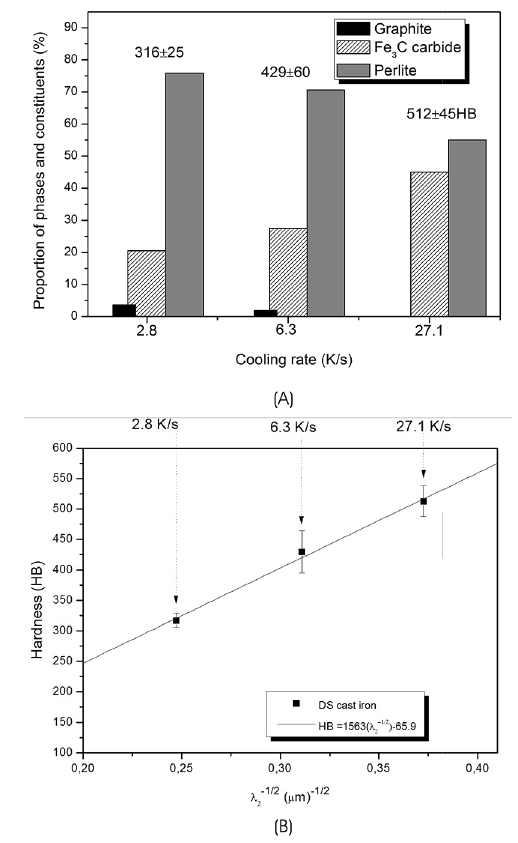
Figure 9: Effects of magnitude of average λ 2 on Brinell hardness along the length of the DS cast iron. The fractions of phases vs. cooling rate complete de analysis. is responsible for better distribution of the harder Fe The combined effects of these features cooperate with the final hardness evolution obtained in DS cast